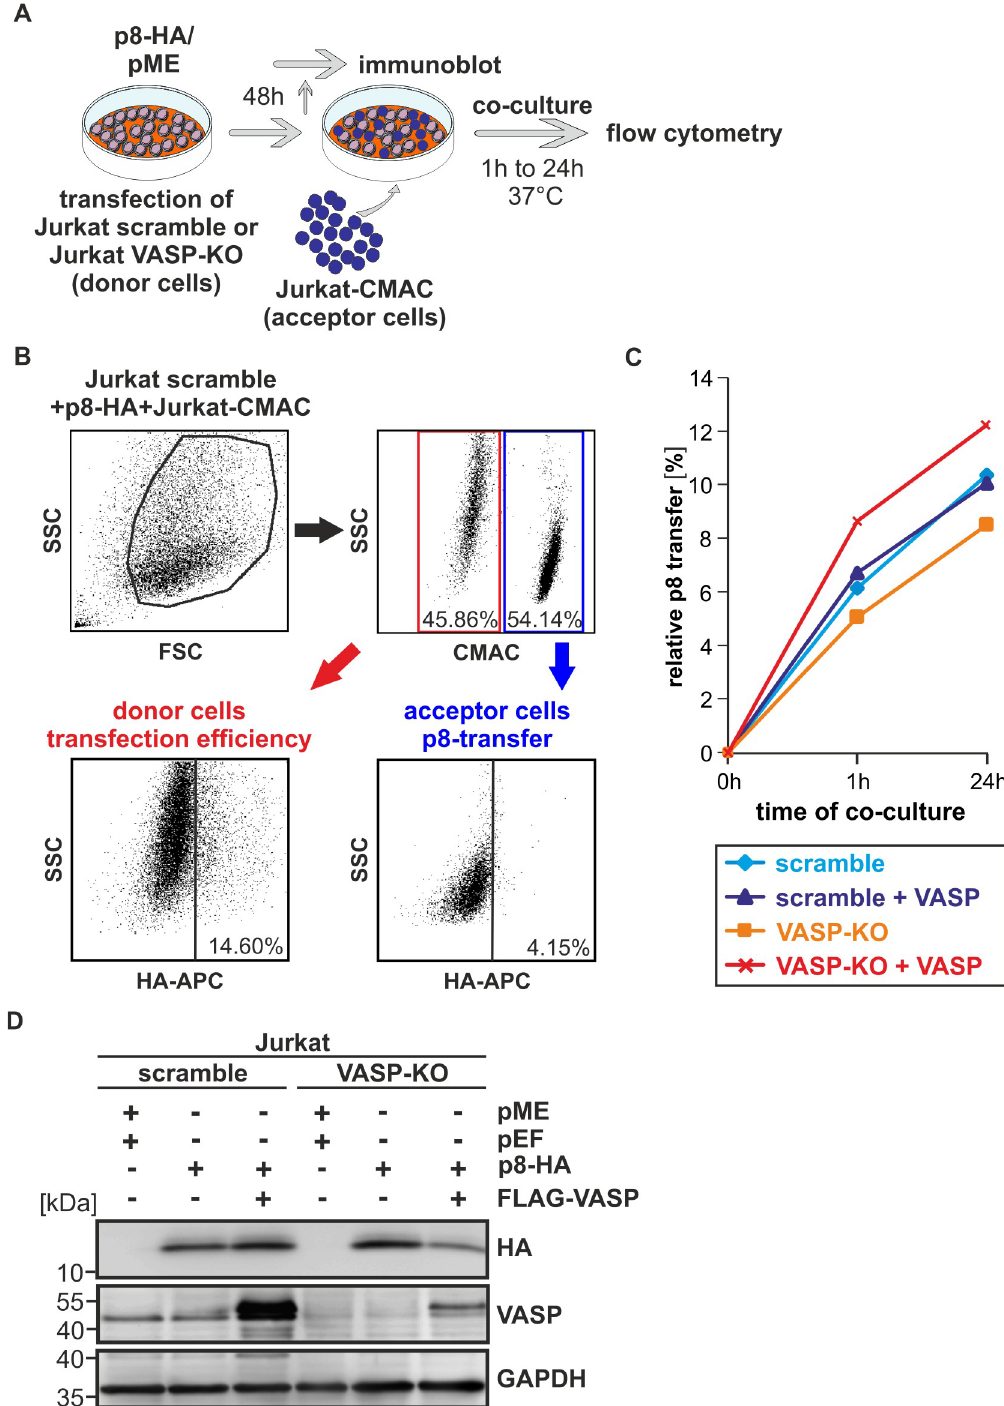
Fig 7. Knockout of VASP impairs p8-transfer between Jurkat T-cells. (A) Experimental setup. (B-D) Stably transduced Jurkat T-cells (guide scramble, VASP-KO) were transfected with p8-HA expression plasmids or a control plasmid (pME) and FLAG-VASP or the respective control (pEF-1 α ). At 48 h post transfection, cells were either (B-C) co-cultured with pre-stained target Jurkat T-cells (Jurkat-CMAC; ratio 1:1, 37˚C) for 0 h, 1 h, or 24 h and subjected to flow cytometry, or (D) cells were lysed for immunoblot analysis (B-C) Flow cytometry. At 48 h post transfection, equal amounts of donor and acceptor cells (1x10 6 cells each) were either directly fixed in 2% PFA and mixed (time point: 0 h), or they were co-cultured at 37˚C for 1 h or 24 h before fixation. After intracellular staining using HA-specific, APC-labeled antibodies or the respective isotype-matched